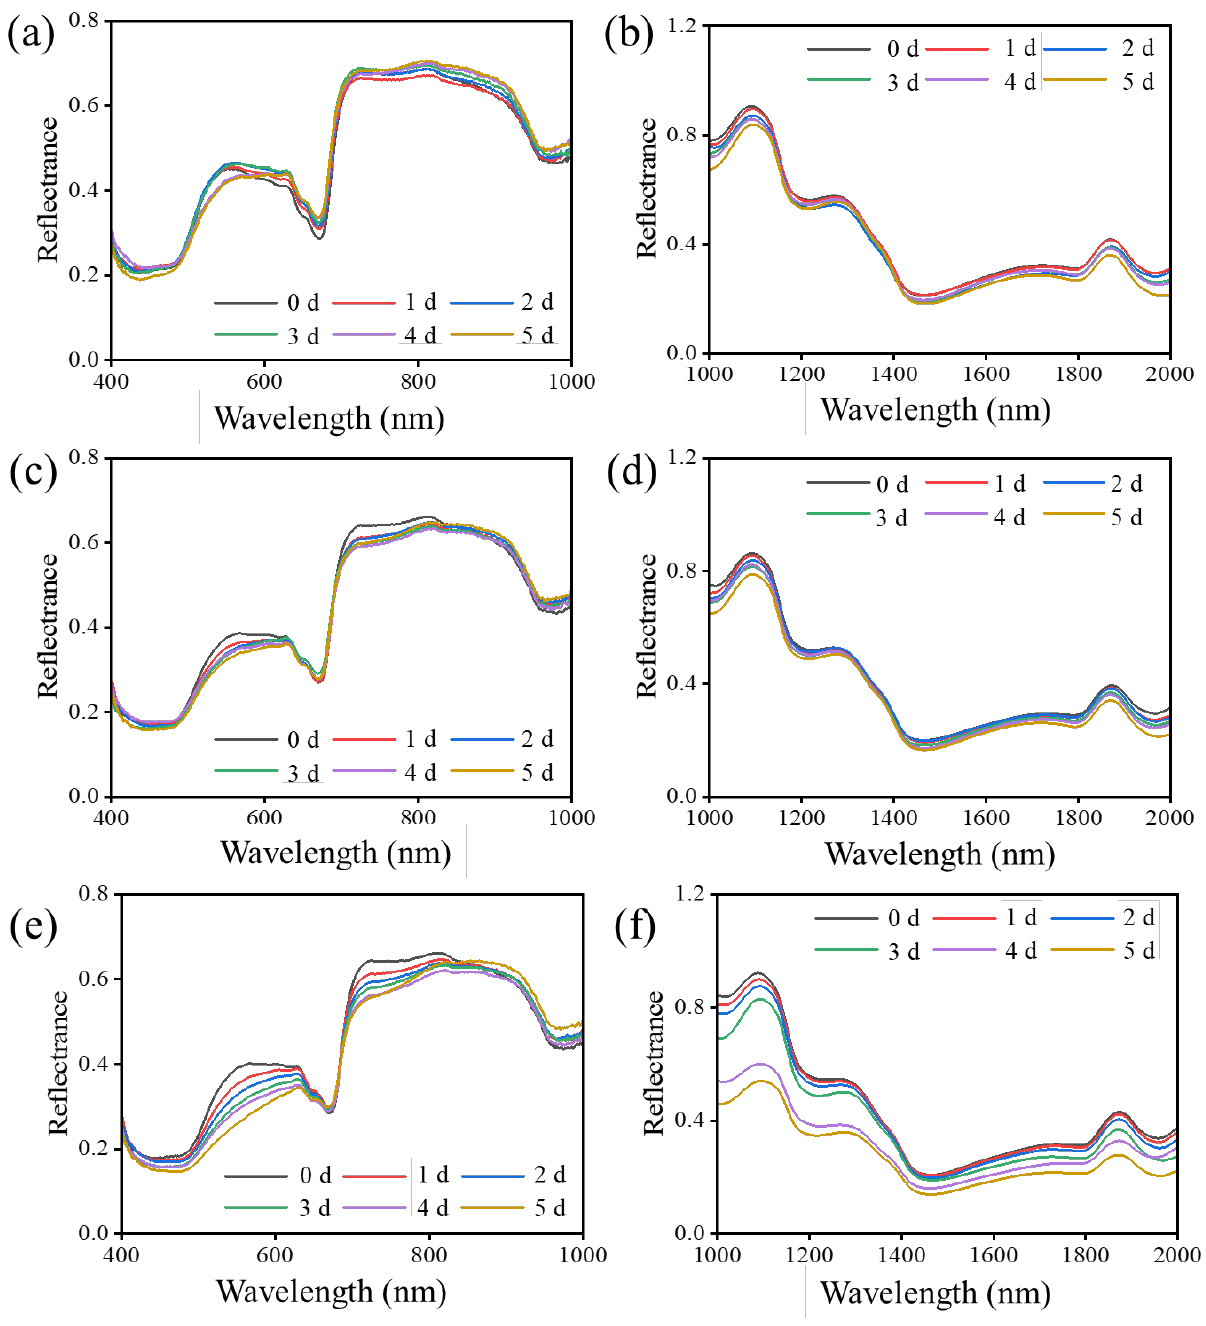
Figure 3. Mean spectra of control groups and infected groups during the storage at 20 °C in the Vis-NIR (400–1000 nm) and SWIR (1000–2000 nm) region. ( a ) Mean spectra of control group I (healthy samples without treatment) in the Vis-NIR region; ( b ) Mean spectra of control group I in the SWIR region; ( c ) Mean spectra of control group II (samples inoculated with sterile water) in the Vis-NIR region; ( d ) Mean spectra of control group II in the SWIR region; ( e ) Mean spectra of infected group (samples inoculated with A. alternata ) in the Vis-NIR region; ( f ) Mean spectra of infected group in the SWIR region.